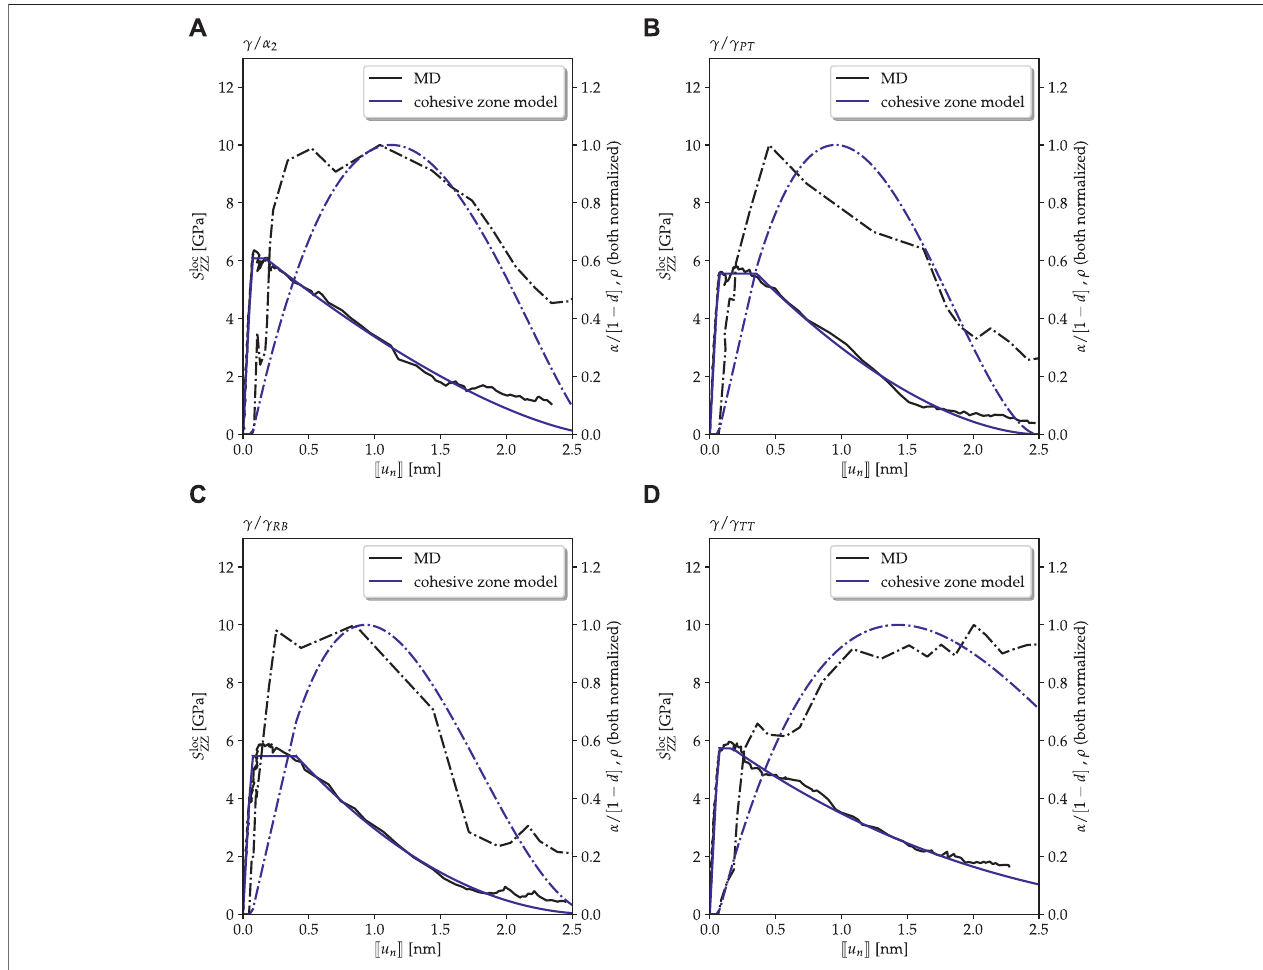
FIGURE 9 | Interfaces with defects (Type-2 interface model): traction – separation curves as observed in MD simulations (solid black lines) compared to the ones of cohesivezonemodels withparameters fi ttedtotheresultsoftheMD simulations (solid blue lines)at atemperature T (cid:2) 900Kand strainrate _ ε glo ZZ (cid:2) 10 9 / s for (A) c / α 2 , (B) c / c c / c c / c PT , (C) RB ,and (D) TT interfaces.Thedashed linesdenote thenormalizeddislocation density corrected interface plasticity α / [ 1 − d ] in the cohesive zone model (blue).